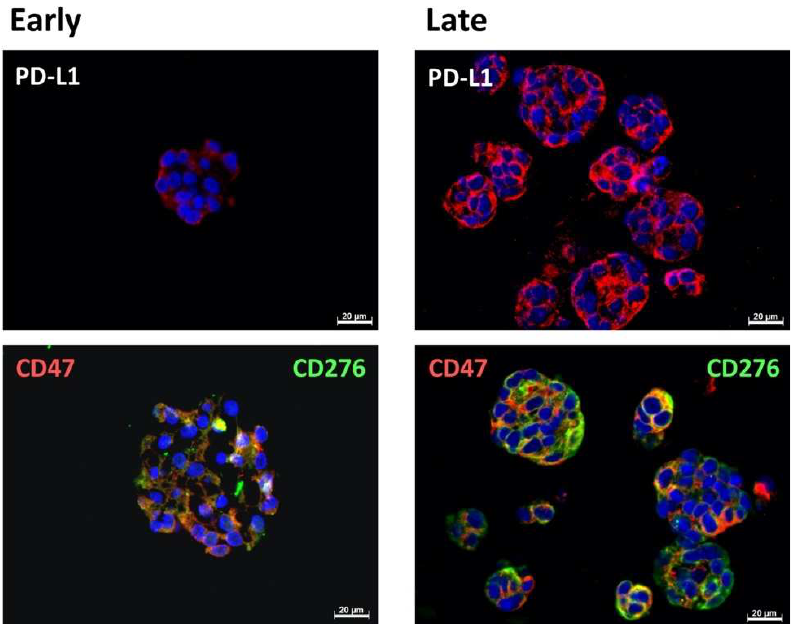
Figure 4. Expression of immune checkpoint antigens on BCO#140. Paraffin sections of organoids of BCO#140, a population with high in vitro growth capacity, were generated and stained in early passage ( left panel ) or in later passage ( right panel ) with antibodies reactive with PD-L1, CD276, and CD47 as indicated. In the bottom panel, CD47 is visualized by red fluorescence, CD276 by green fluorescence. Size bars indicate 20 μm, respectively.